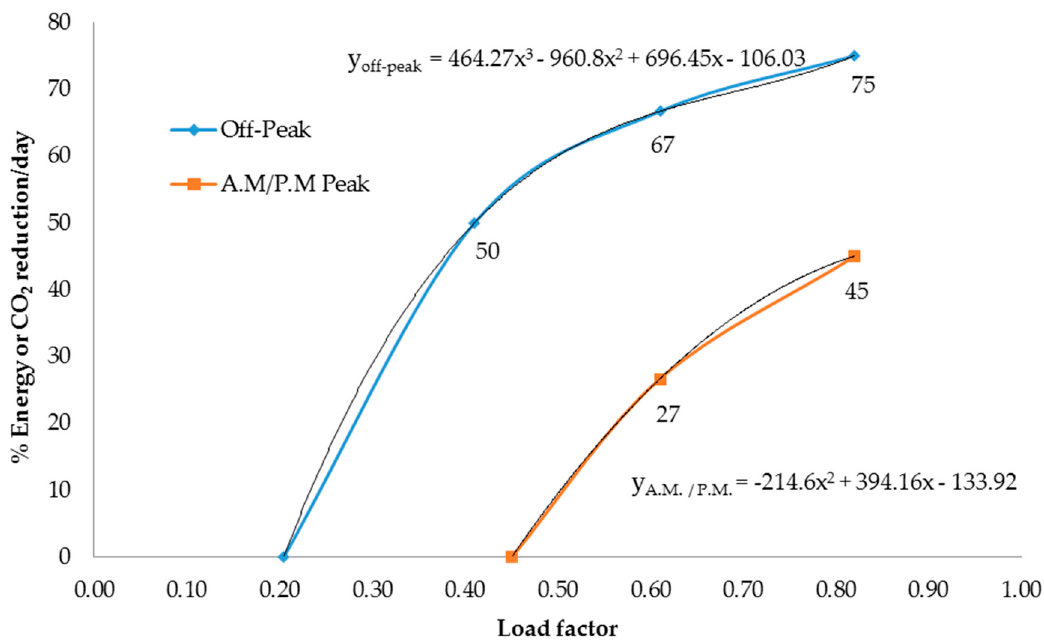
Figure 9. The Relationship between the Percentage of Energy or kgCO 2 Reduction after Applied PBRU and Load Factor during the a.m. peak (Y A.M. ), Off-peak (Y off-peak ), and p.m. Peak Times (Y P.M. ).